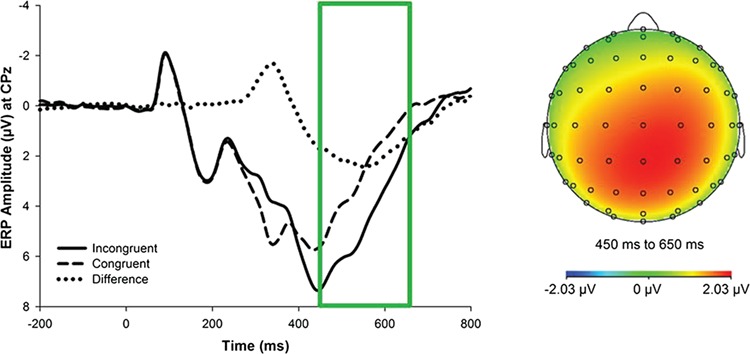
Left: stimulus-locked, grand average waveforms depicting congruent P3, incongruent P3 and ΔP3 amplitudes at electrode CPz. Time 0 is the stimulus onset. Right: scalp topography depicting voltages of the ΔP3, quantified as the average activity between 450 and 650 ms following stimulus onset.